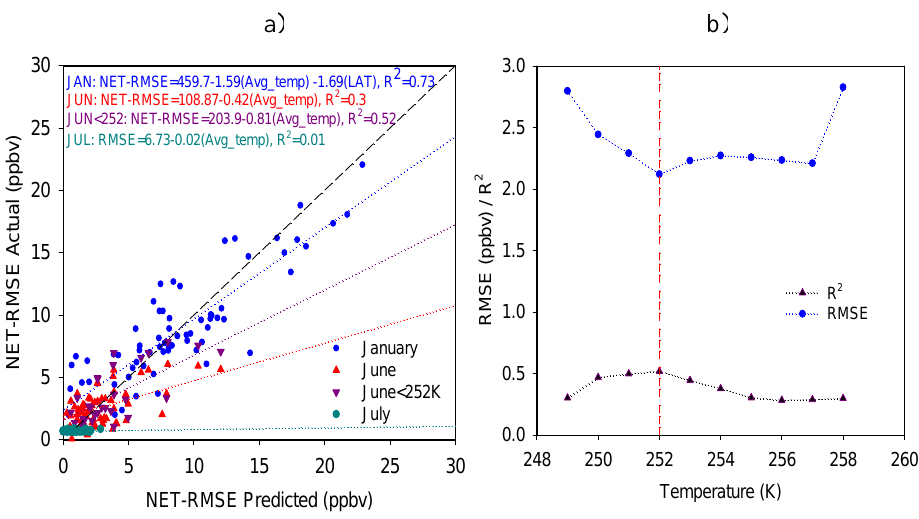
Fig. 10. Statistical analysis outputs from CASTNET sites: a) NET-RMSE actual Vs. Fig. 12. Statistical analysis outputs from CASTNET sites: (a) NET-RMSE actual vs. NET-RMSE predicted, (b) sensitivity analysis on best-fit equation for June NET-RMSE predicted, b) sensitivity analysis on best-fit equation for June data.